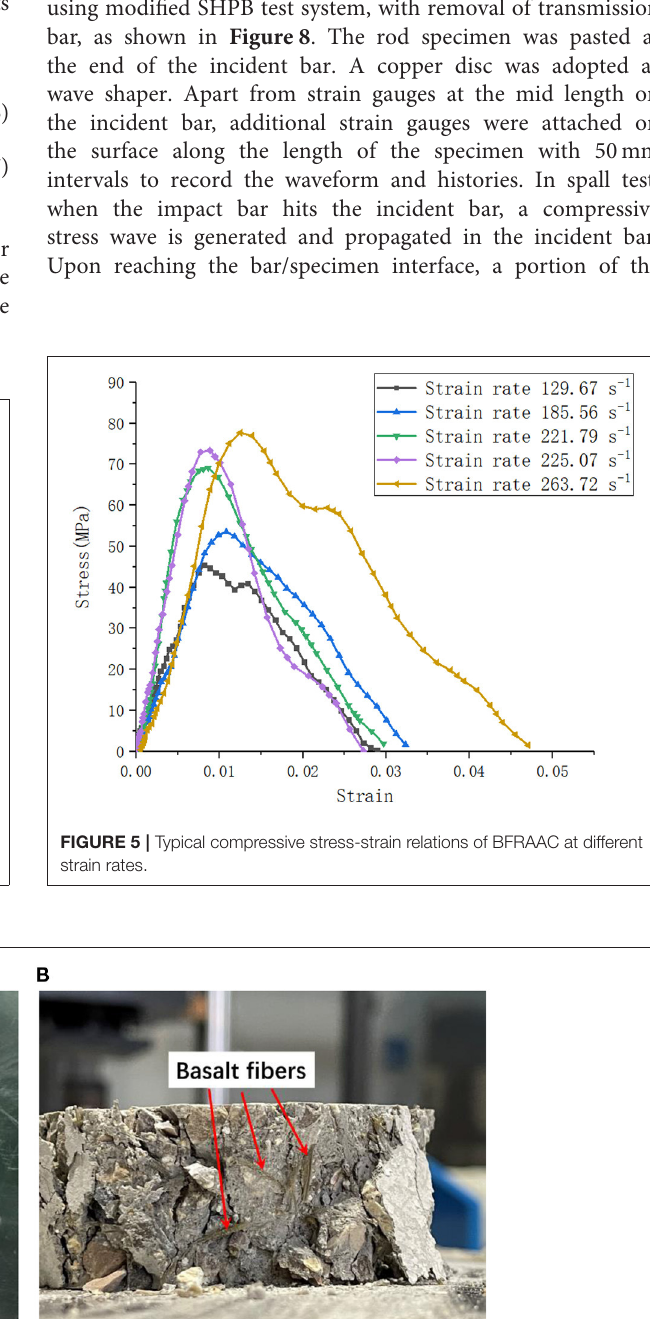
Frontiers in Materials |